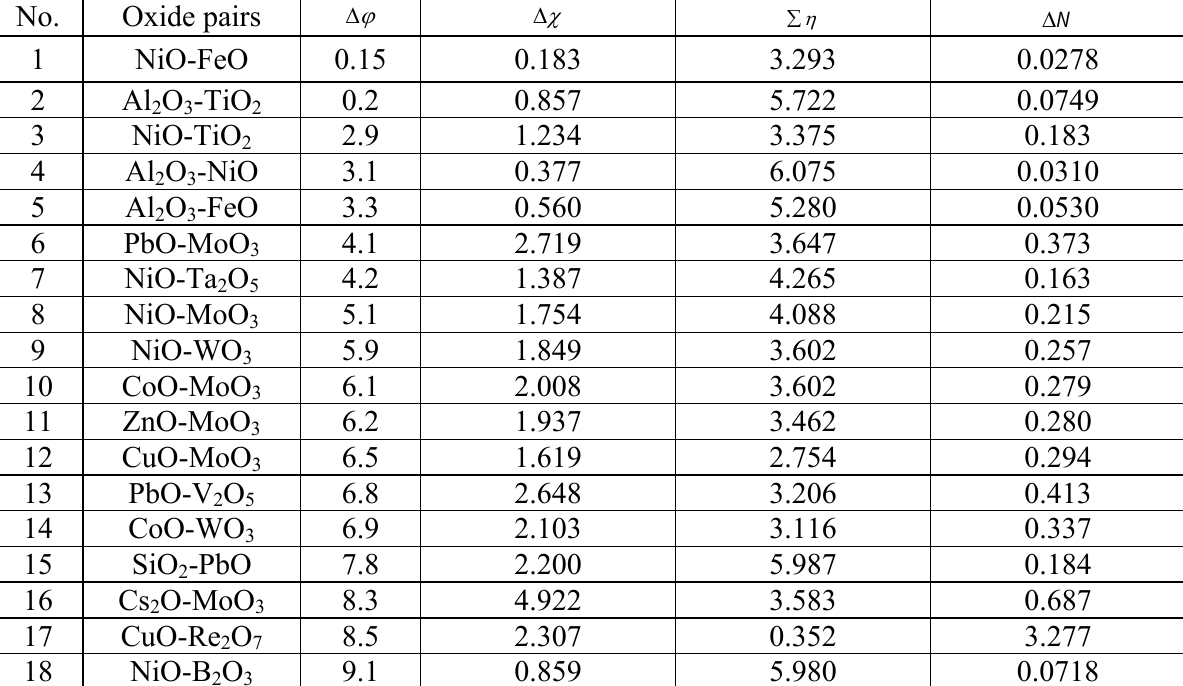
Table 3. Calculated values of fractional numbers of transferred electrons for contacting oxide pairs a